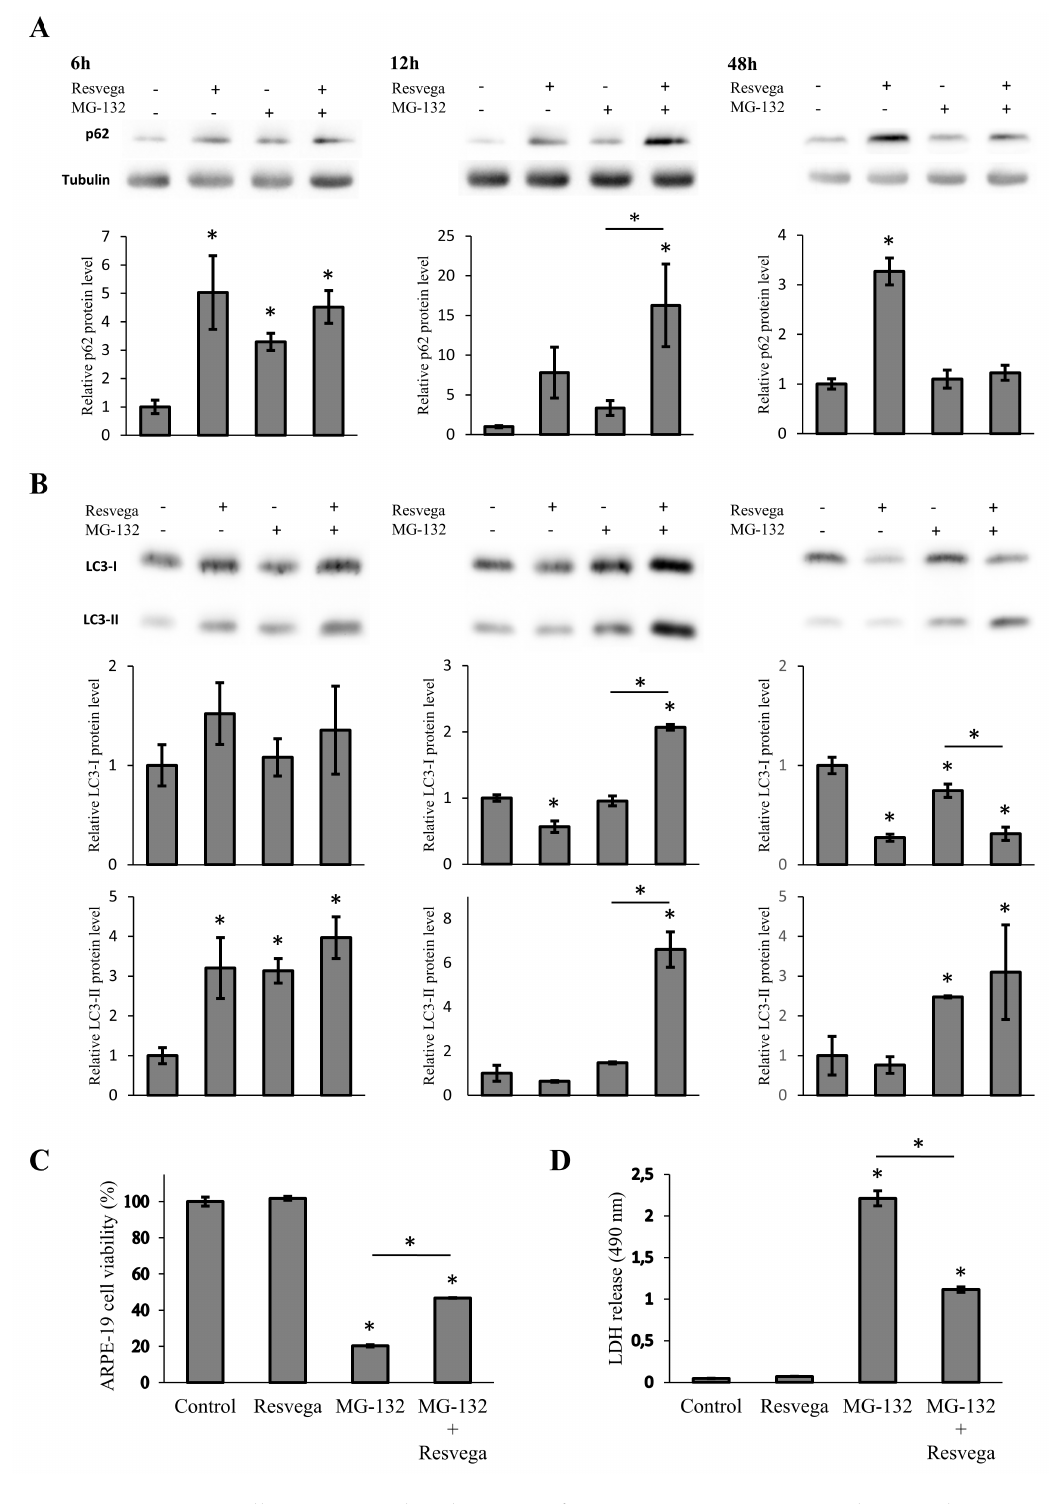
Figure 2. ARPE-19 cells were treated with 288 ng of Resvega, 1 µ M MG-132 or their combination for 6 h, 12 h, and 48 h under serum starvation. The protein levels of p62 ( A ) and LC3-I/LC3-II ( B ) were analyzed by Western blot, while the expression was quantified in comparison to α -tubulin and presented as a fold change compared to control; the cells were treated for 48 h and MTT ( C ) and LDH ( D ) assays were performed. Western blot data are shown as mean ˘ SD ( n = 3), MTT assay data as mean percentage (control = 100%) ˘ SD ( n = 3) and LDH assay data as mean absorbance ˘ SD ( n = 3). * p < 0.05,